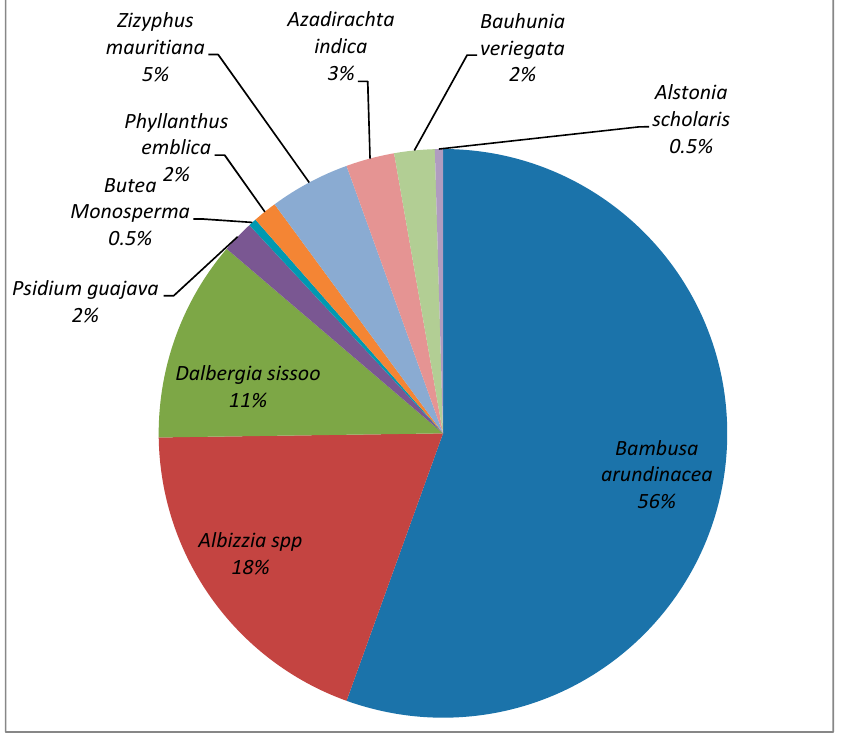
Figure 5. Relative density of each species in the RMS showing the percentage of each species in the study area.